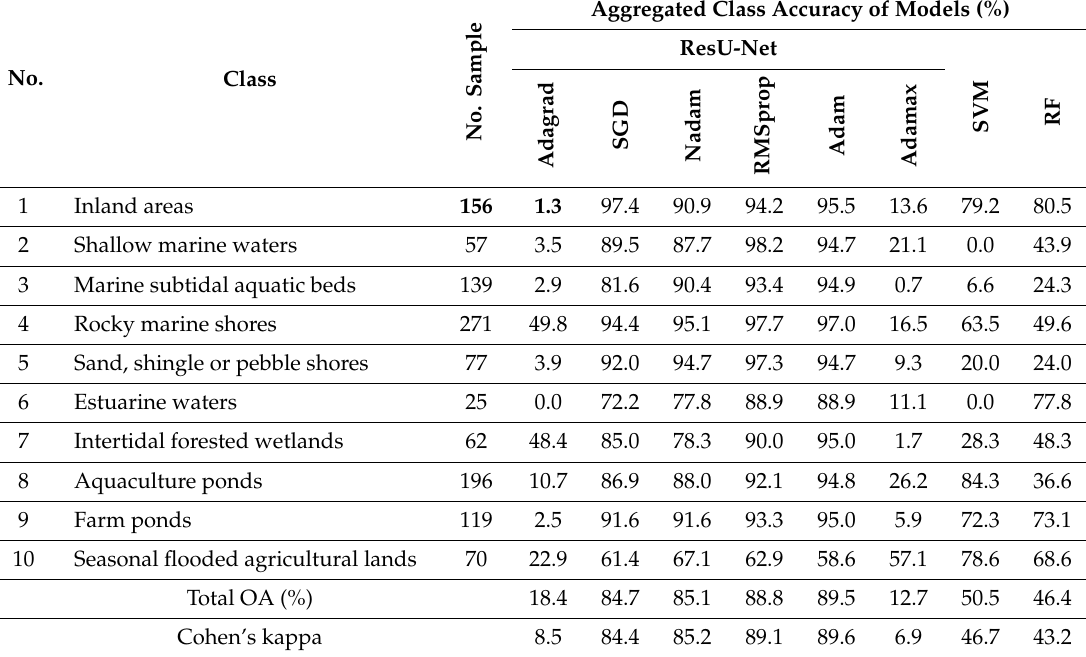
Table 4. The cross-validation results of eight models for the coastal wetland